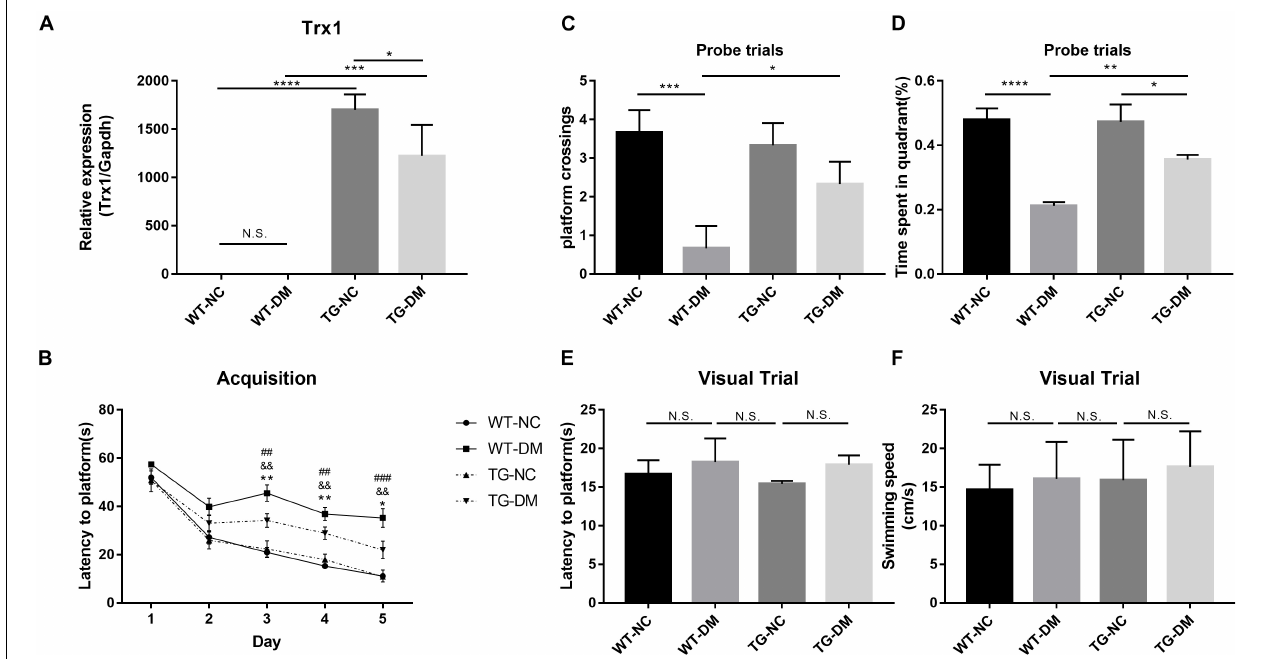
FIGURE 1 | Trx-1 mRNA levels in the hippocampal tissues of the mice and neurobehavioral analysis of Trx-1 transgenic mice. (A) Real-time quantitative PCR of Trx-1 mRNA levels in mouse hippocampal tissue. (B) Latency to platform, ## p < 0.01: WT-NC vs WT-DM; && p < 0.01: WT-DM vs TG-DM; * p < 0.05, ** p < 0.01: TG-NC vs TG-DM. (C) Platform crossing (probe trial), (D) Time spent in the target quadrant (probe trial). (E) Latency to platform (visual trial). (F) Swimming speed. Tukey’s post hoc test for one-way ANOVA was used to determine Trx-1 mRNA levels. For each group, n = 6. The vertical lines represent the standard error of the mean. * p < 0.05, ** p < 0.01, *** p < 0.001, and **** p <